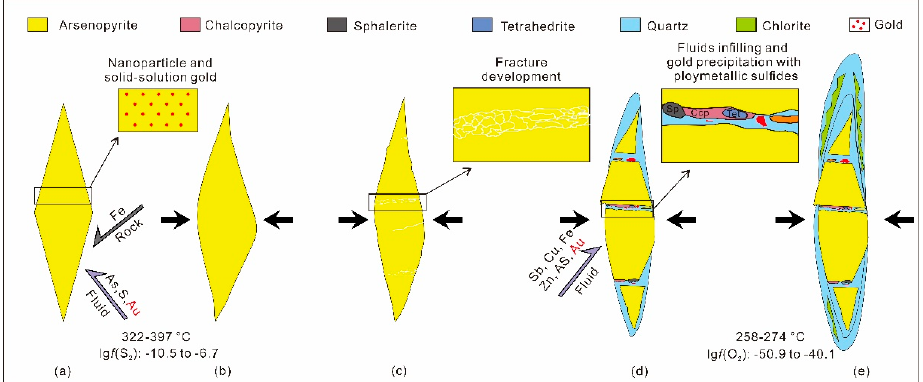
Figure 10. Simplified model interpreting the process and mechanism of deposition of minerals including gold. ( a ) Euhedral arsenopyrite with invisible gold disseminated in the altered slates; ( b ) Arsenopyrite underwent initial crystal plastic deformation; ( c ) Fractures development in arsenopyrite; ( d ) Fluids containing Sb, Cu, Zn, As and Au filled in the fractures and other dilational sites of arsenopyrite leading to gold and polymetallic sulfides precipitation. ( e ) Chlorite precipitated in the pressure shadow microstructure with minor gold.